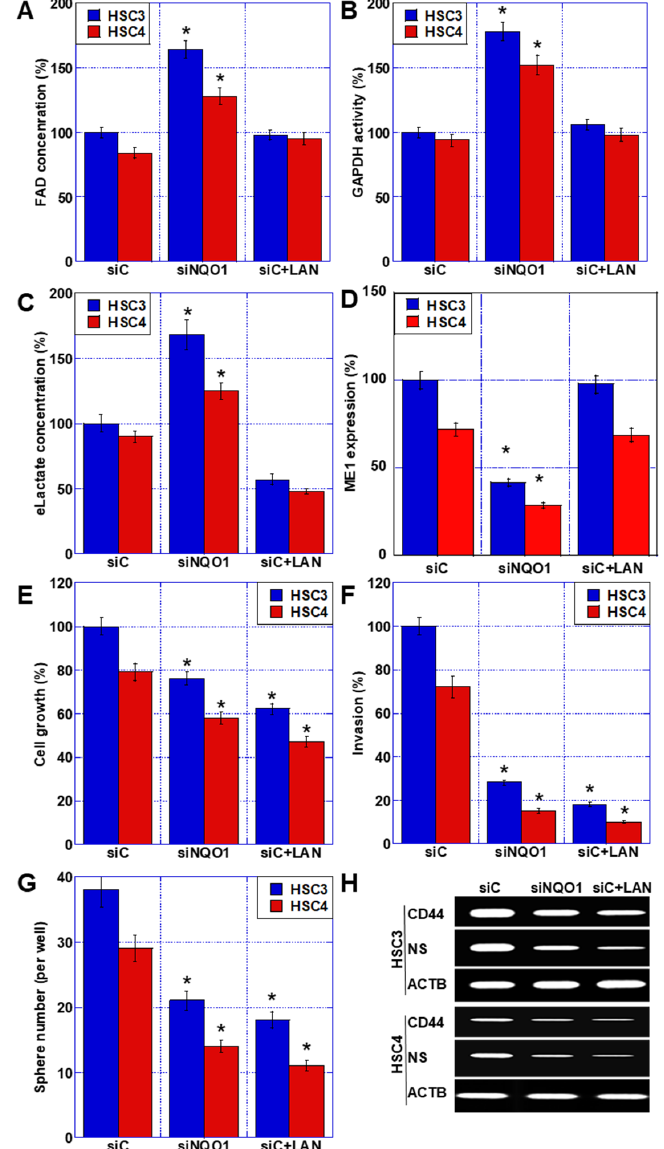
Figure 4. Role of NQO1 in malignant phenotypes in OSCC cells. ( A – D ) Effect of NQO1 knockdown or ME1 inhibition (LAN, 1 μ M) for 48 h on FAD concentration ( A ), GAPDH activity ( B ), extracellular lactate ( C ), and ME1 expression ( D ). ( E – G ) Effect of NQO1 knockdown or ME1 inhibition on